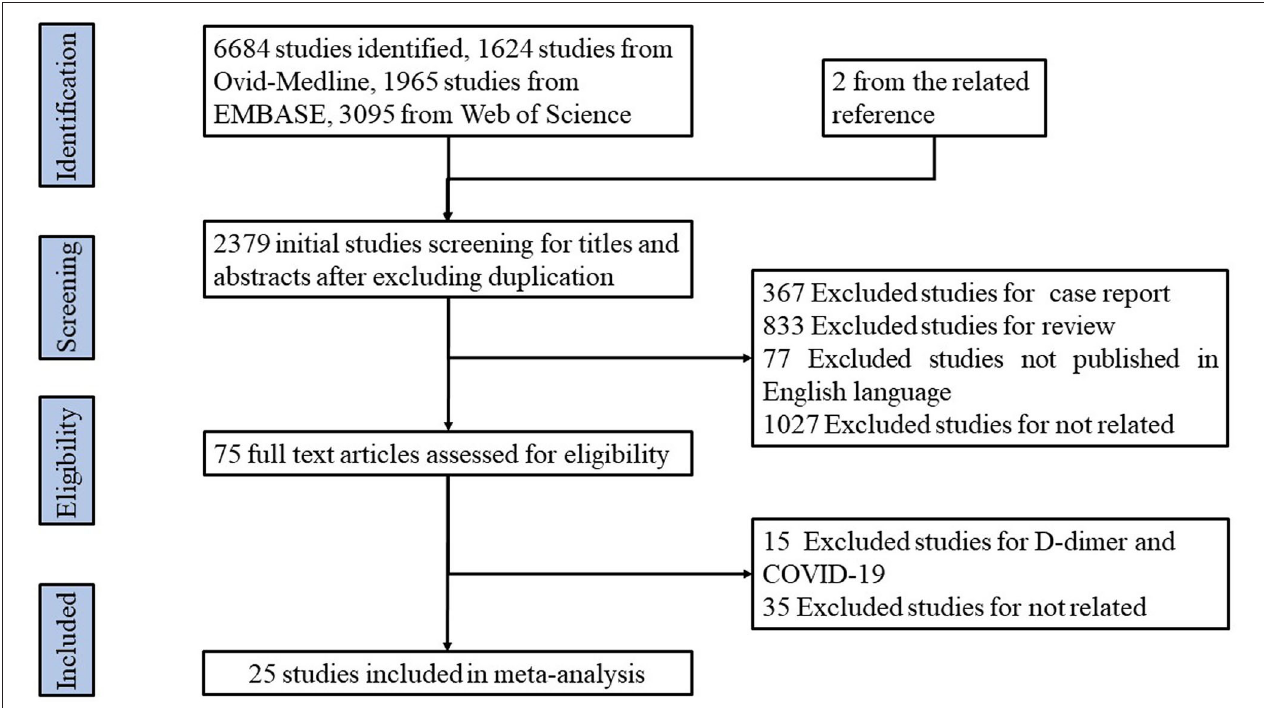
FIGURE 1 | A flow chart describing study